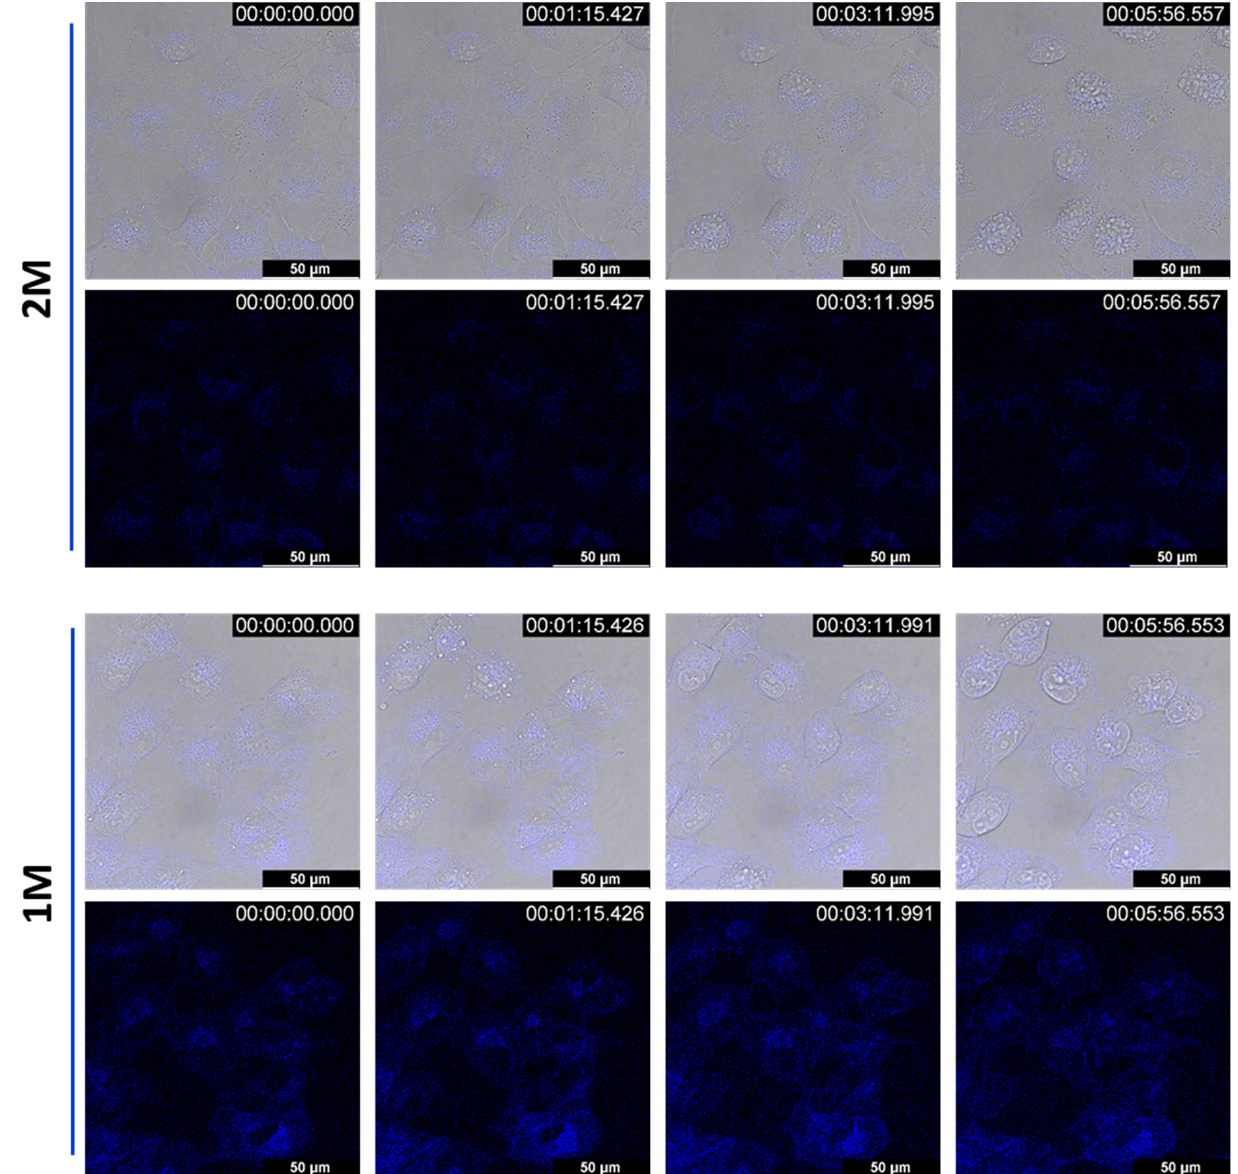
Figure 9. Confocal time-lapse imaging of A549 cells treated with 2M or 1M (1 µM) and irradiated at maximum diode power at λ exc = 350 nm, monitored by bright field and fluorescence ( λ em = 420–500 nm) during 6 min. Note severe blebbing in the cells and complete disintegration after only 3 min irradiation, while non-treated cells did not change.